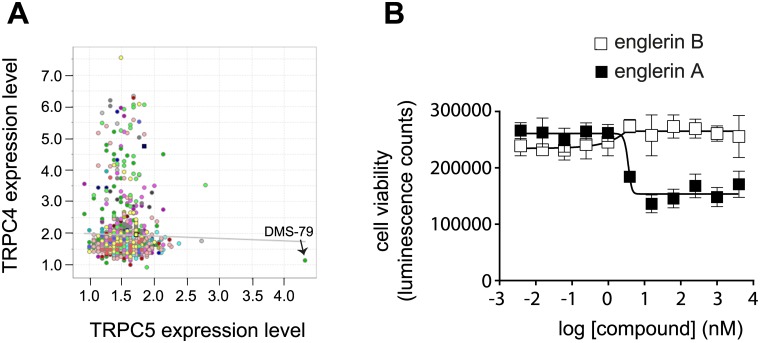
Overexpression of TRPC5 can also confer sensitivity to englerin A.(A) Expression of TRPC4 and TRPC5 in the cell lines from the CLiP experiment. Each circle represents a single cell line and expression levels were measured by microarray (TRPC4 probe 220818_s_at, TRPC5 probe 220552_at). The circle representing the DMS-79 cell line is indicated. (B) The effect of englerin A on cell viability in HEK293T cells transiently transfected with a vector expressing TRPC5 (mean +/- standard deviation).